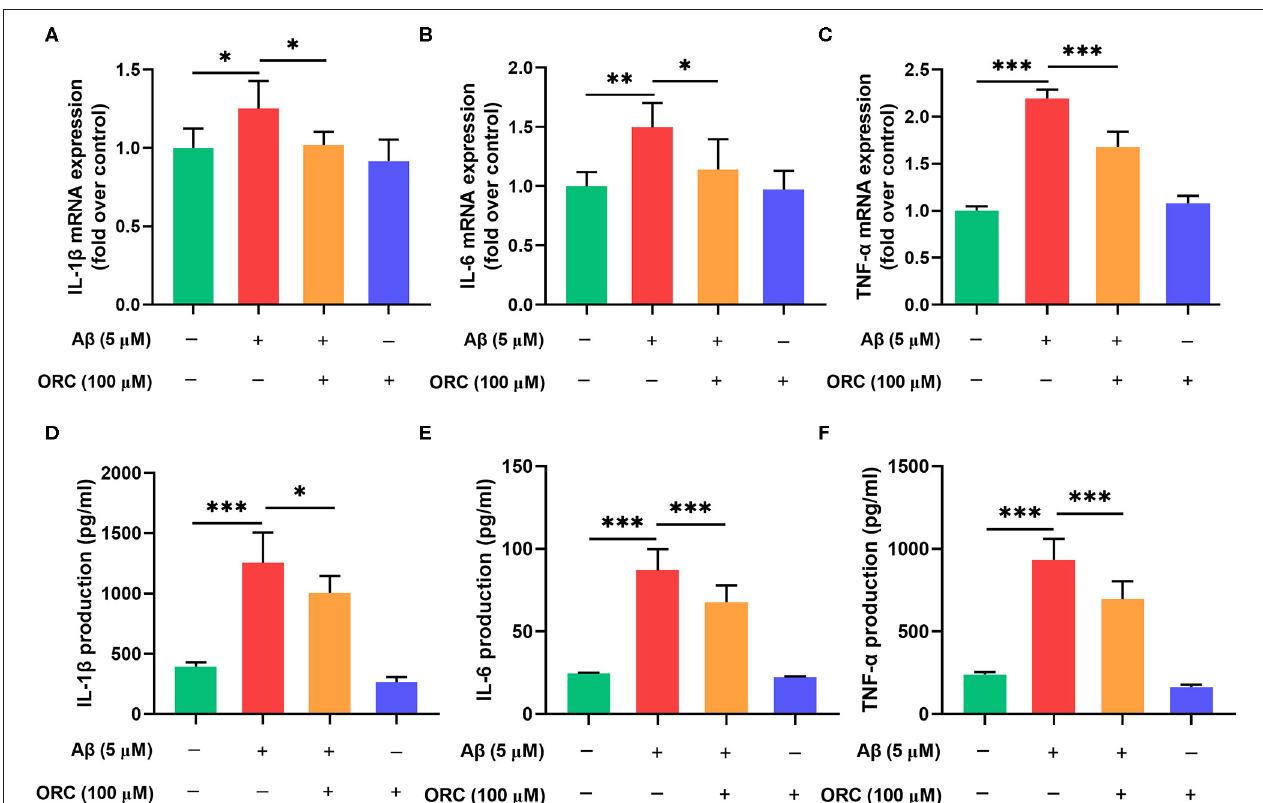
FIGURE 4 | Inhibitory effects of oxiracetam (ORC) on pro-inflammatory cytokine mRNA and protein levels. BV2 microglial cells were treated with A β in the presence or absence of ORC. The mRNA levels of IL-1 β (A) , IL-6 (B) , and TNF- α (C) were determined using qRT-PCR ( n = 6 for all groups). The levels of IL-1 β (D) , IL-6 (E) , and TNF- α (F) proteins were examined using ELISA ( n = 7 for IL-1 β and TNF- α , n = 9 for IL-6). All values are presented as the mean ± standard deviation. * p < 0.05, ** p < 0.01, and *** p <